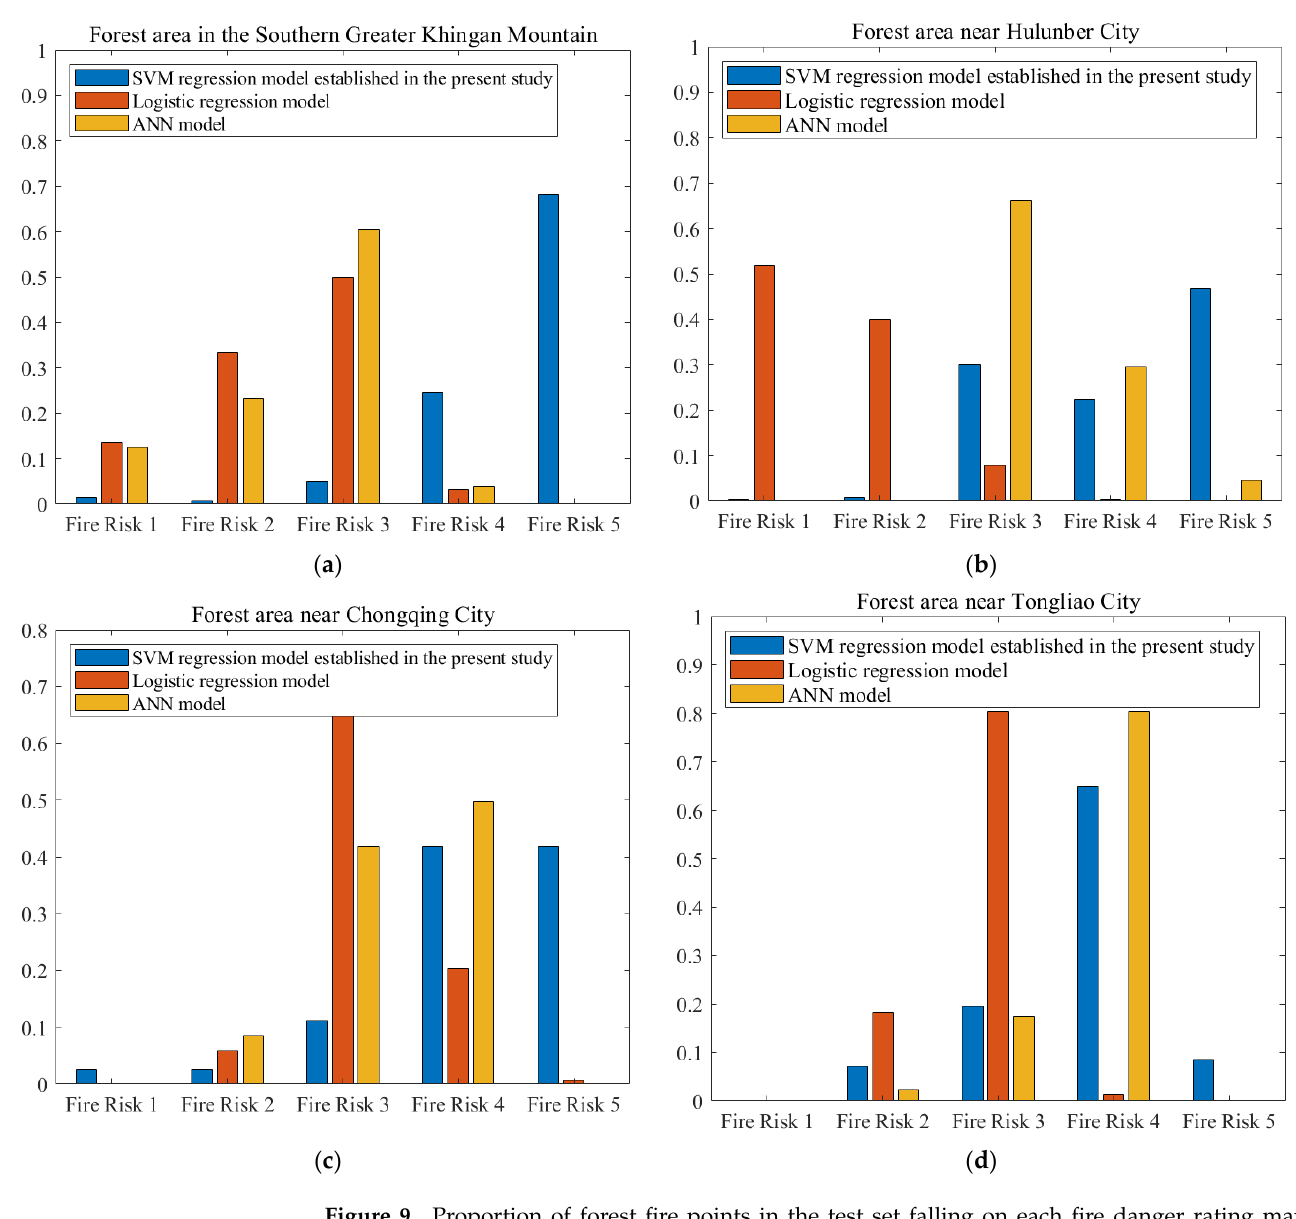
Figure 9. Proportion of forest fire points in the test set falling on each fire danger rating map established by three different methods: ( a ) forest area in the southern part of Greater Khingan Mountains; ( b ) forest area near Hulunber city; ( c ) forest area near Chongqing city; ( d ) forest area near Tongliao city.